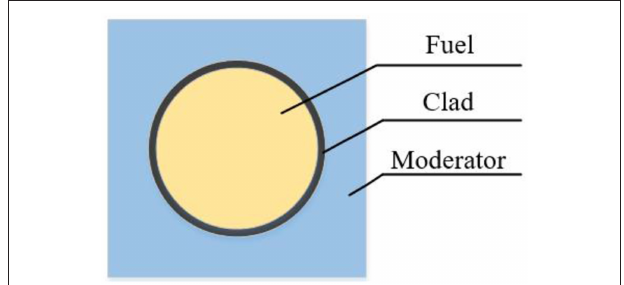
FIGURE 4 | Geometry configuration of single fuel